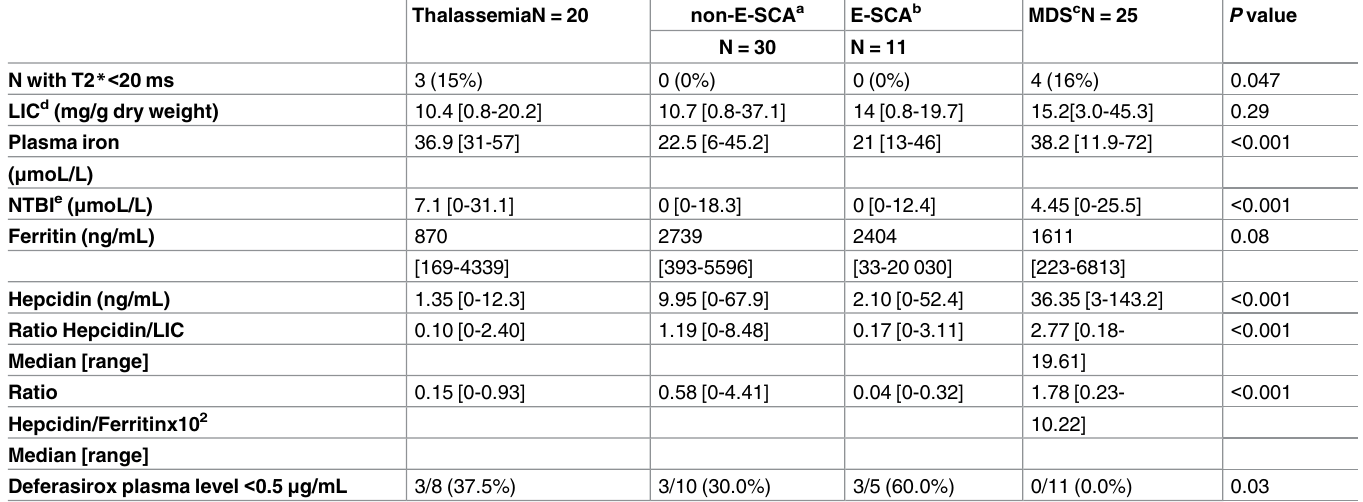
Table 4. Blood iron variables, liver iron content, and T2 * .